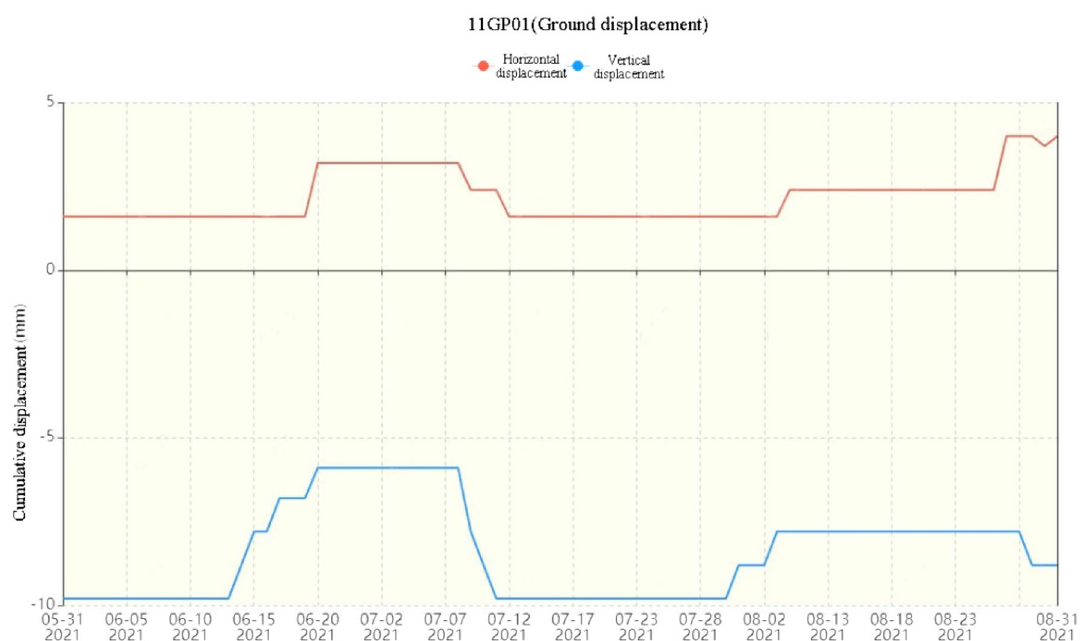
Figure 9. Accumulated horizontal and vertical movement from May 31st to August 31st,